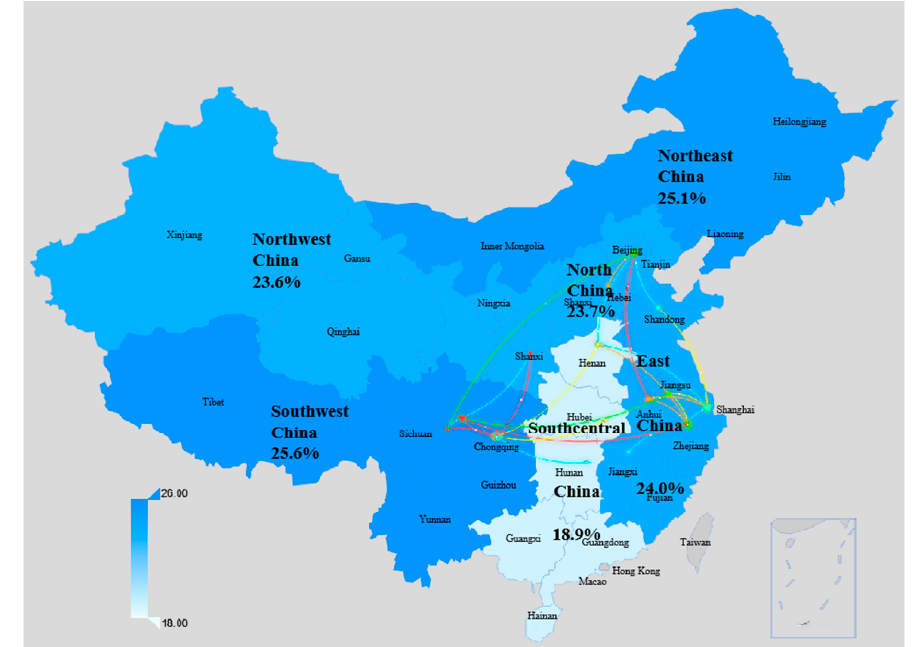
Figure 2. Prevalence of induced abortion among sexually active migrant women by origin of the floating population in China, 2014. The lines represent population migration from the top five sources (provinces) for each survey site.